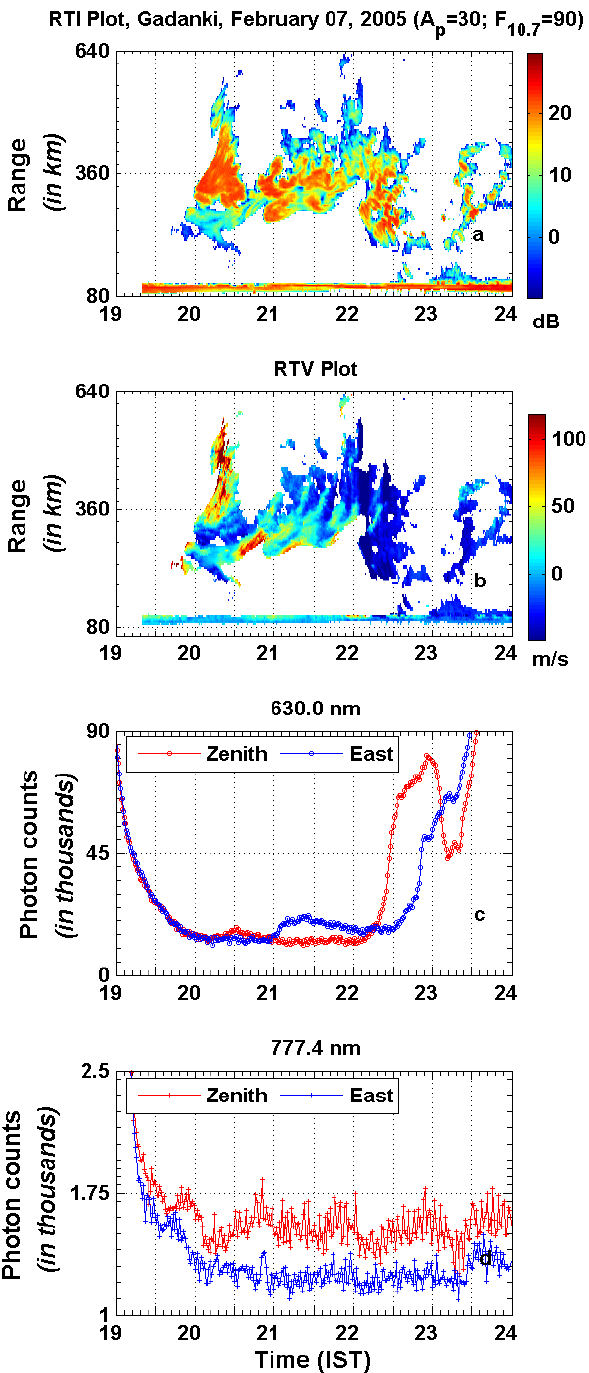
Fig. 2. Similar to Fig. 1 but for 7 February 2005 revealing wave-like bottomside structure with large altitude